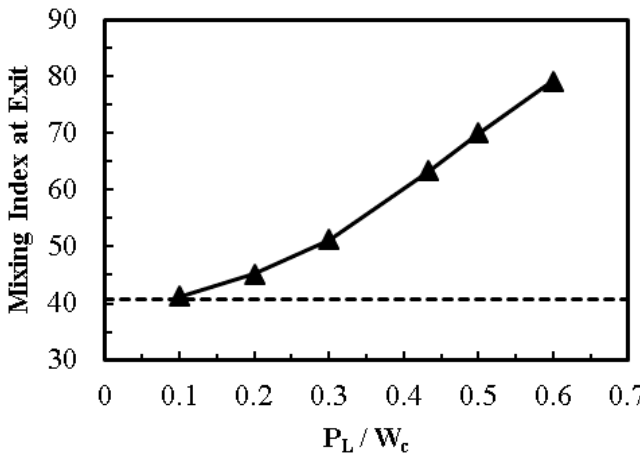
Figure 11. Effect of P L / W c on mixing index at the exit (homogeneous channel, dashed line; heterogeneous channel, solid line with symbols).